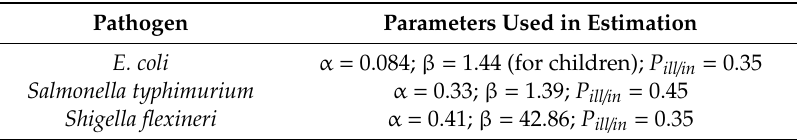
Table 1. Dose-response assessment